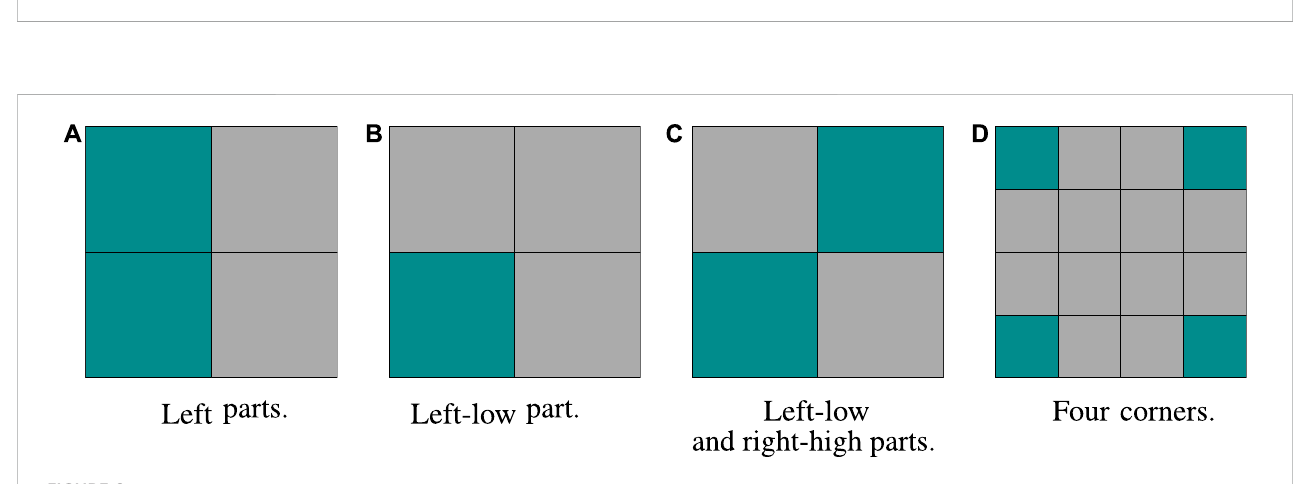
As mentioned previously, the computational efforts will be reduced when truncating eigensoultions in mapping the radiation modes for evaluating NNI and sound power. Figure 5 shows the Radiated sound power and truncation number versus frequency. In Figure 5A, we compare the sound power computed by sound intensity and NNI resulting from mapping truncated radiation modes, and these two results match very well. We also investigate the truncation number to achieve 99% accuracy compared with the sound power computed by sound intensity in Figure 5B. From the result, we notice that a truncation number of 4 is acceptable for the calculation with a frequency range of 200 Hz. In fact, the sound power is dominantly contributed by the fourth radiation mode because the particle velocity corresponds to the fourth modal pattern. This can be con fi rmed by investigating the coupling factor of particle velocity with the radiation modes [33]. The coupling factor between the particle velocity pattern and the fourth mode is several orders of magnitude larger than the coupling factor with the fi rst three radiation modes. In the